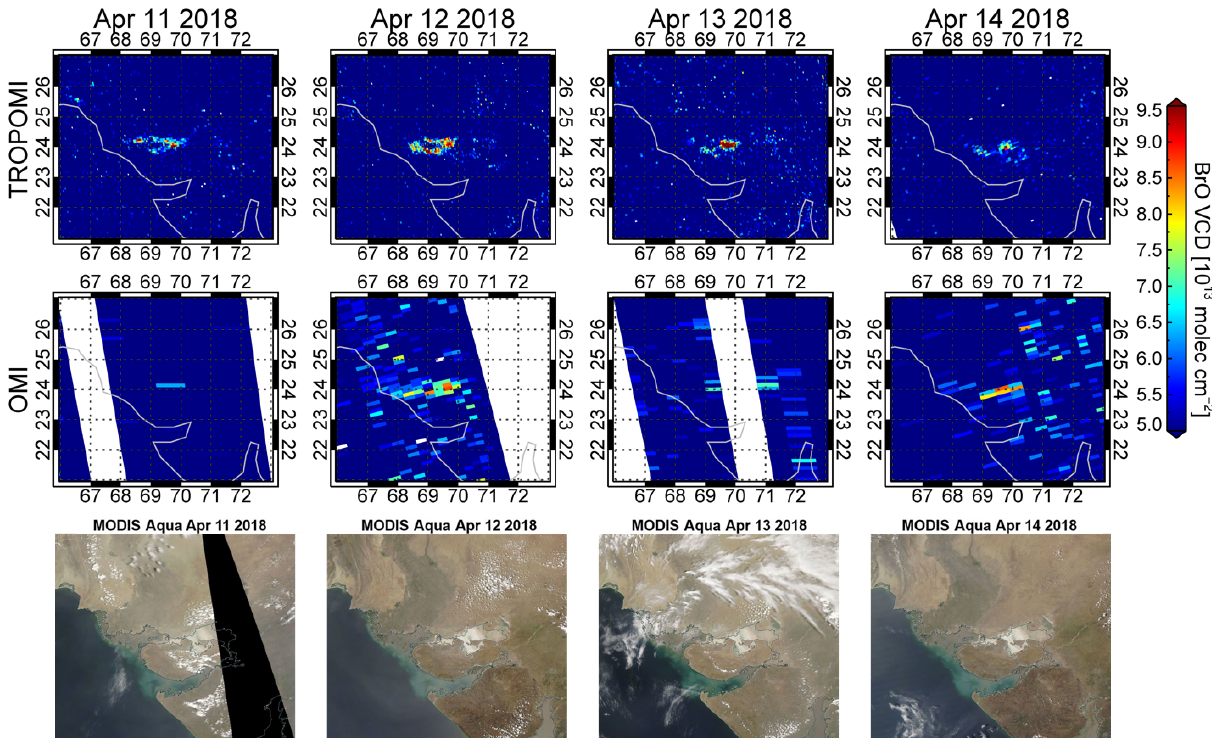
Figure 15. Daily BrO geometric vertical columns (10 13 moleculescm − 2 ) over the Rann of Kutch salt marsh on 11, 12, 13, and 14 April 2018 from TROPOMI (top row) and OMI (middle row) measurements as well as MODIS Aqua true color images over the study region for the same days (bottom row).